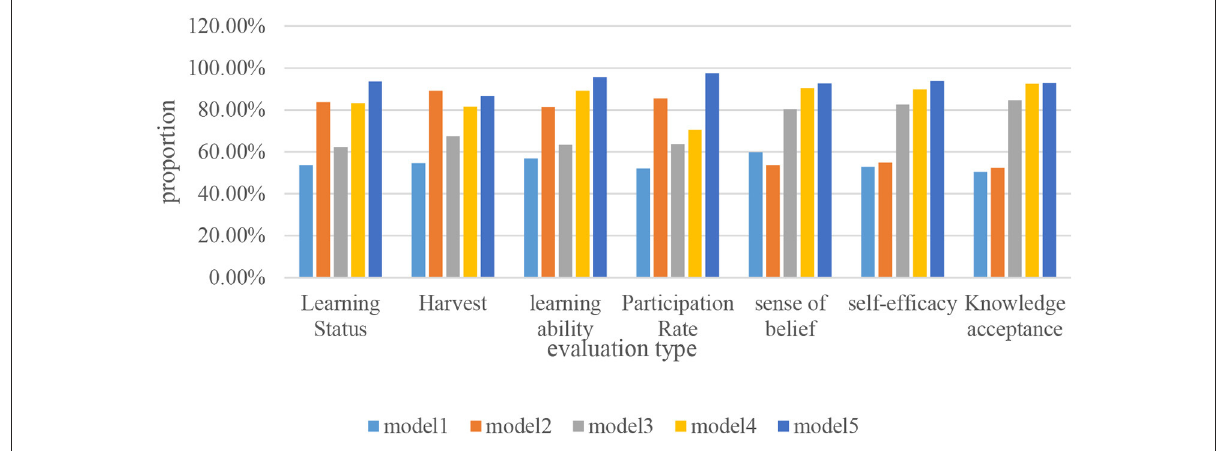
FIGURE6 Students’ evaluation of different teaching modes.